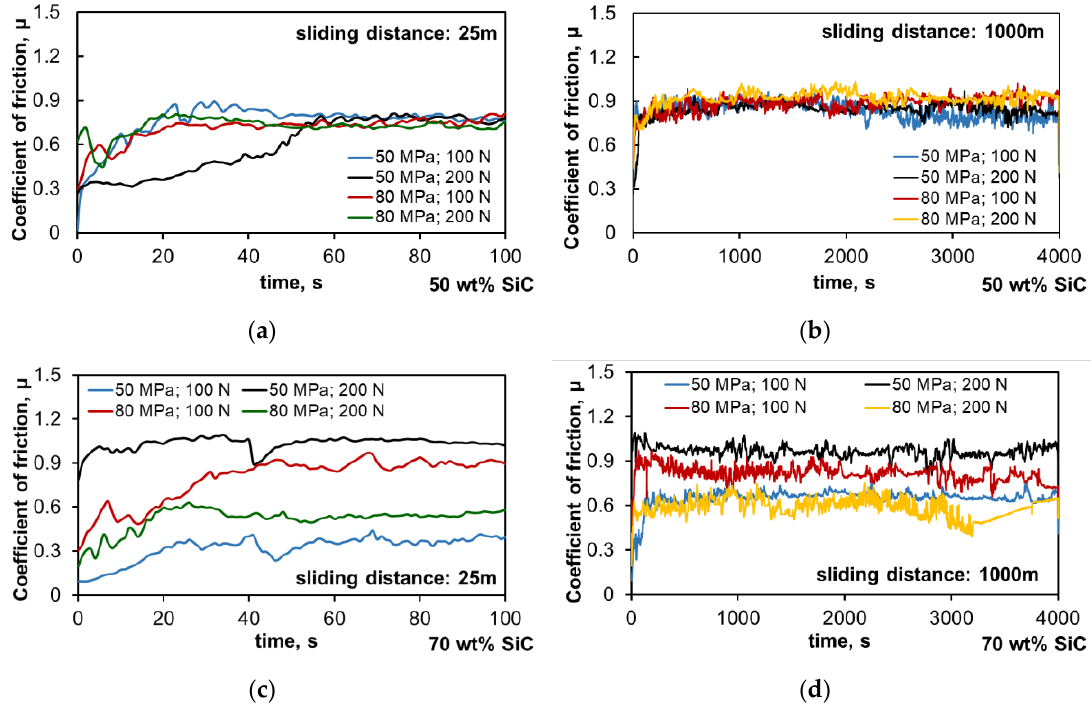
Figure 6. Coefficient of friction as a function of time: ( a ) Al-50SiC, run-in period—sliding distance 25 m, ( b ) Al-50SiC, whole test—sliding distance 1000 m, ( c ) Al-70SiC, run-in period—sliding distance 25 m, ( d ) Al-70SiC, whole test—sliding distance 1000 m.